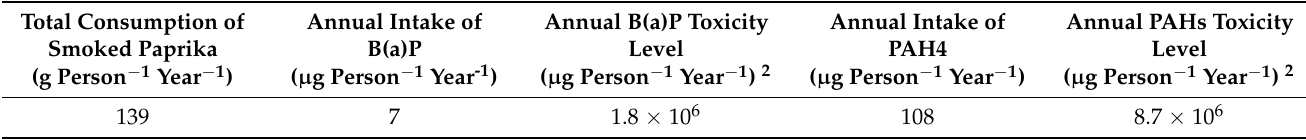
Table 5. Comparison between the levels of annual intake of PAHs from consumption of smoked paprika against the annual toxicity levels established according to European Food Safety Authority (EFSA)’s recommendations. Total Consumption of Smoked